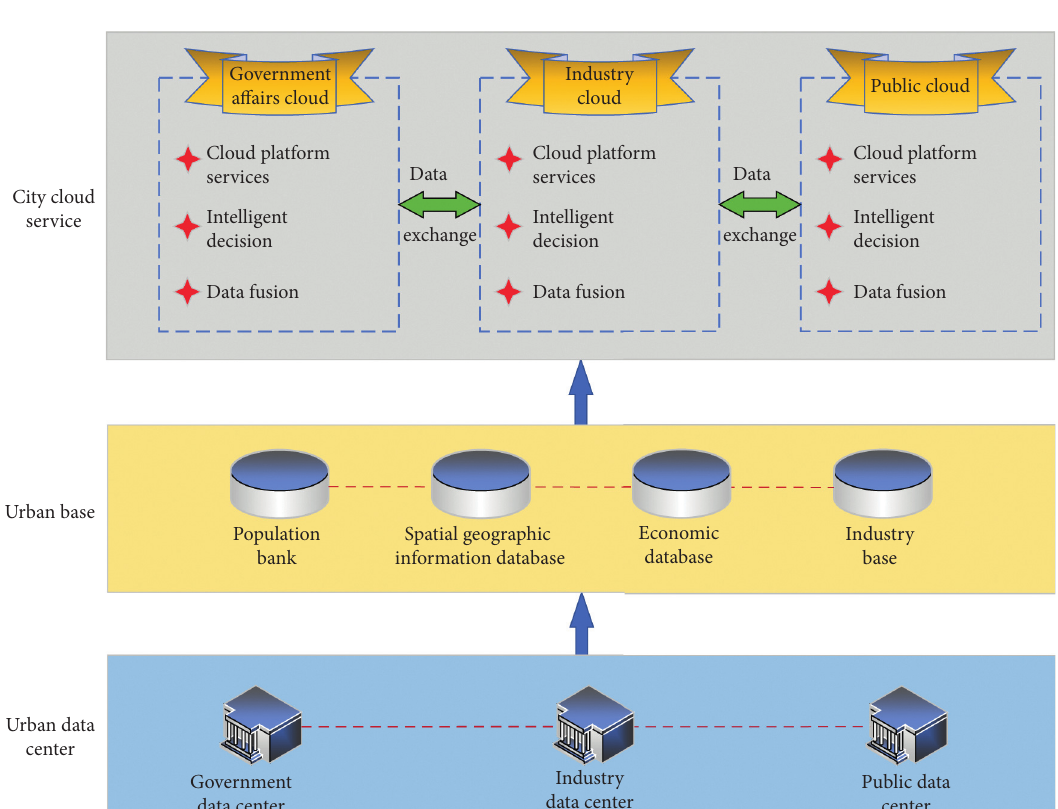
Figure 2: The construction of smart city technology system based on big data cloud